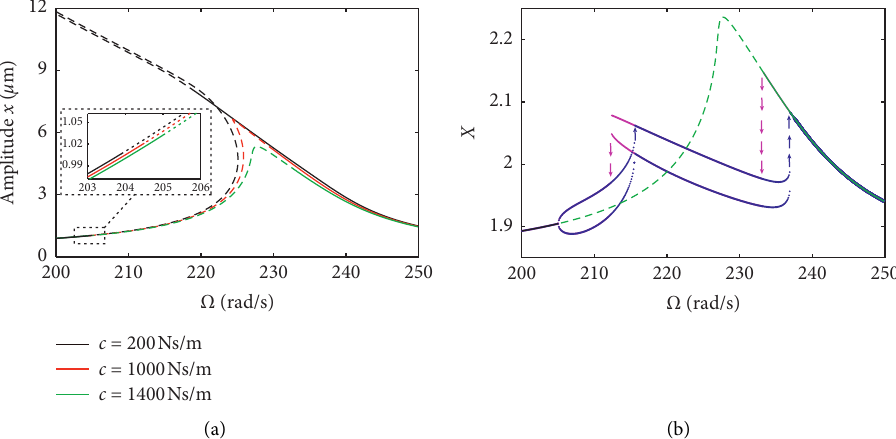
Figure 7: Influence of damping on (a) period-1 frequency-response peak-to-peak curves in the x -direction and (b) numerical bifurcation diagram of X ( τ ) when Ω is sweeping up (blue dots) and down (magenta dots) for δ 0 � 6.0 μ m and c � 1400Ns/m. Herein, the arrows express the jumping locations and directions of the responses, and solid and dashed lines refer to stable and unstable responses, respectively.